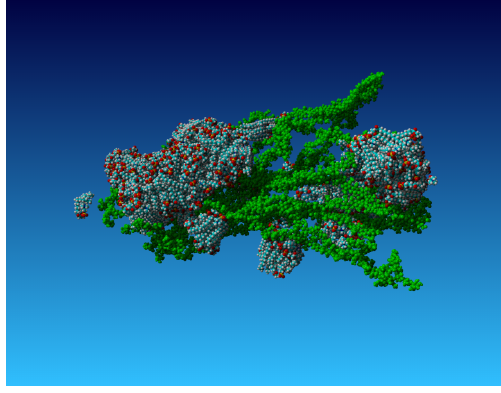
Figure 12. Final structure of 16 HA chains with PL in concentration c 5 = 2 × c 4 . As one can see, PL can penetrate HA network and create micelle-like